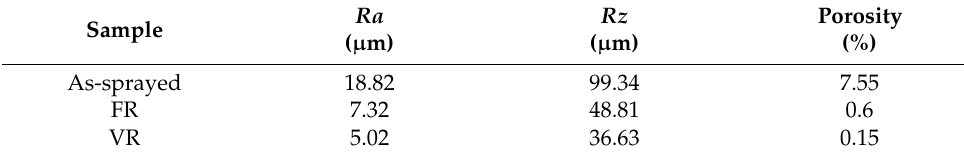
Table 4. Roughness and porosity average measurements of the as-sprayed, FR and VR